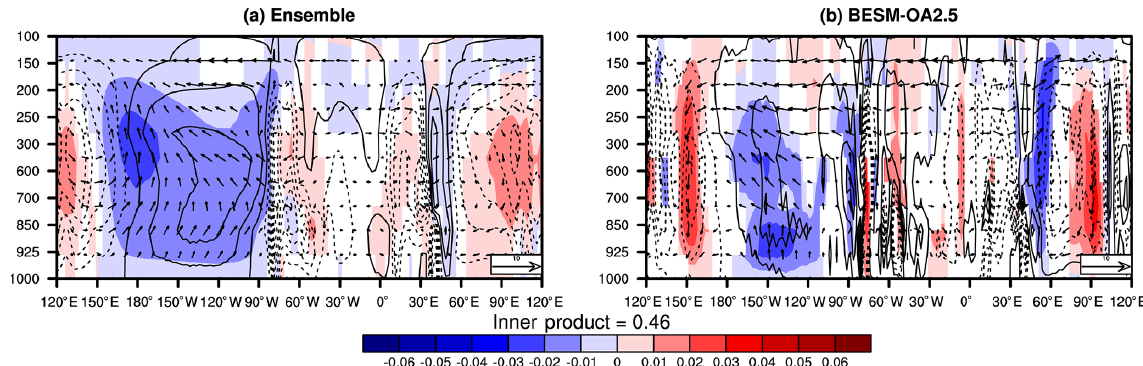
Figure 13. Difference (averaged over years 120–150) between the abrupt4xCO2 and piControl conditions for generalized vertical motion (omega (Pas − 1 ); shaded) and the mean zonal and vertical motion (vectors) averaged between 5 ◦ S and 5 ◦ N for (a) the CMIP5 ensemble and (b) BESM-OA2.5. The contours represents the averaged piControl vertical motion (omega) in the same region. The white regions have confidence levels less than